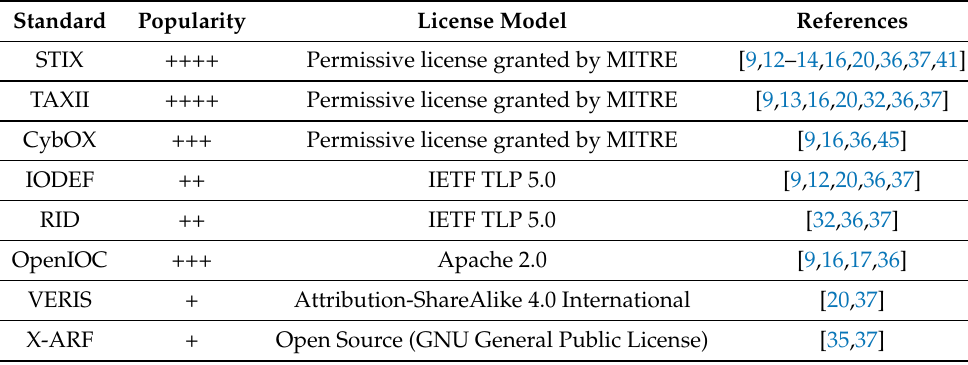
Table 4. Threat Intelligence (TI) standards described by popularity and license